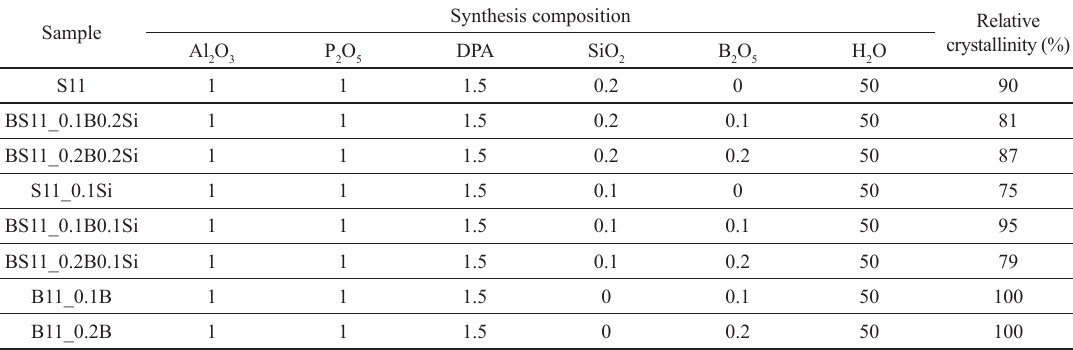
Synthesis composition